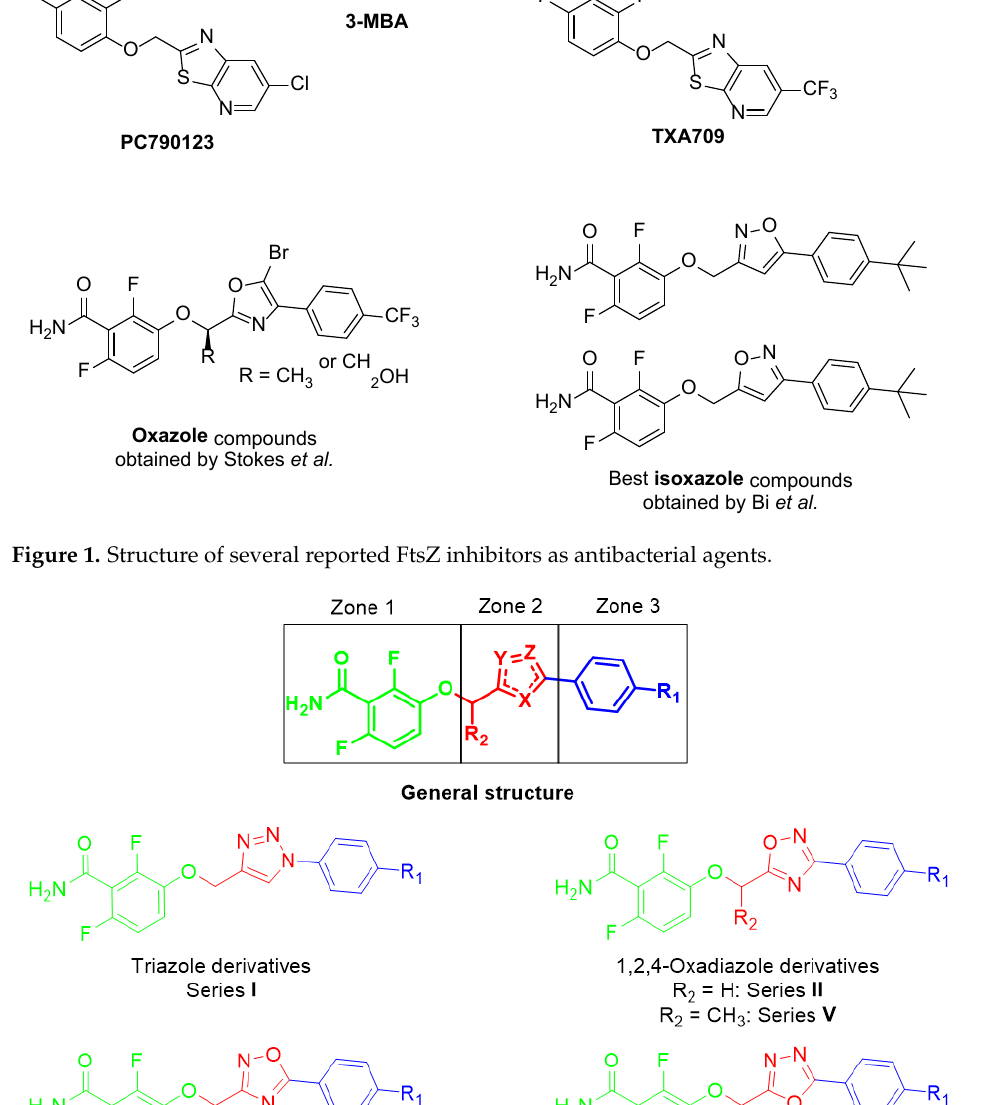
Figure 1. Structure of several reported FtsZ inhibitors as antibacterial agents.